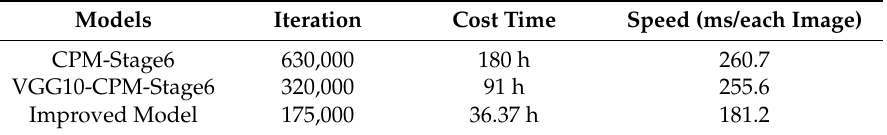
Table 6. The contrasted details of the three models.